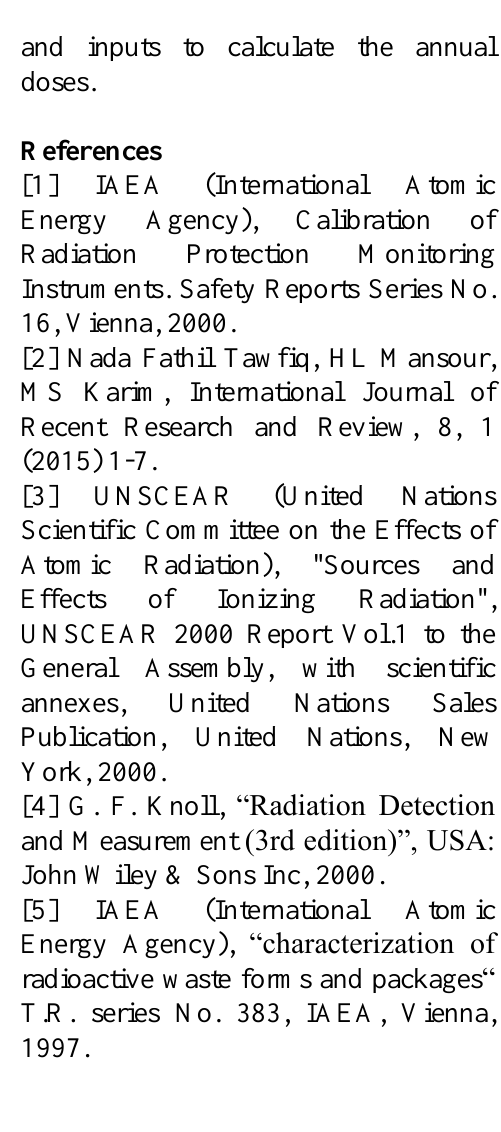
Fig.7: The total dose in germanium system